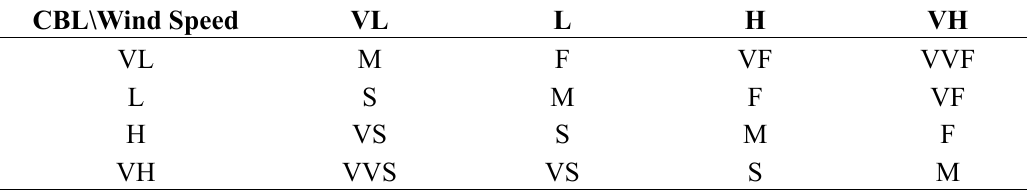
Table 2. Fuzzy rule of battery charging for battery agent in state “2”.